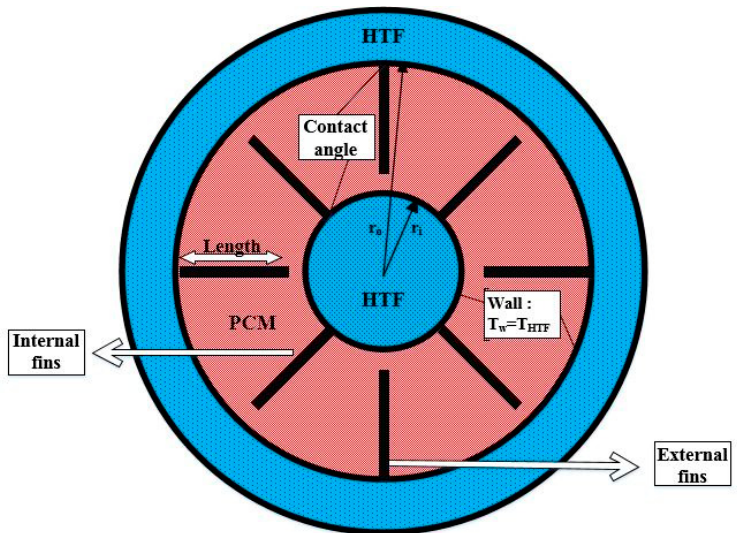
Figure 1. A 2D schematic of the triplex-tube showing the fins’ parameters and configuration (internal fins are those attached to the inner tube while external fins were linked to the outer tube).